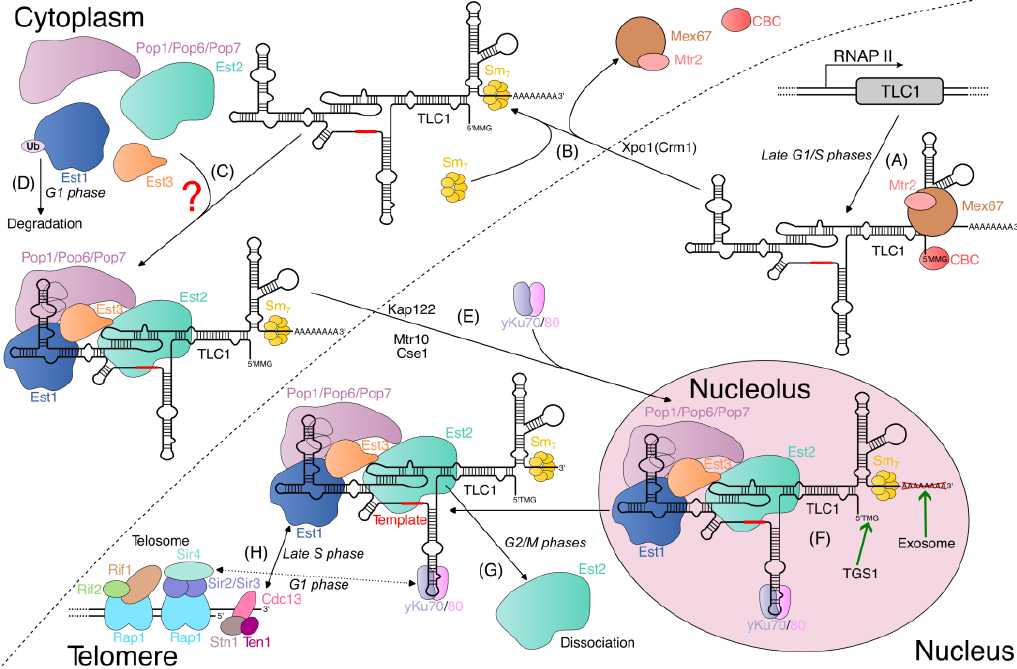
Figure 2. Model of telomerase biogenesis in budding yeast. ( A ) In late G1/S phases, telomerase RNA (TLC1) is synthesized by RNA polymerase II (RNAP II). Immature TLC1 has monomethylated 5′ cap (5′MMG) bound by cap-binding complex (CBC) and 3′ poly(A) tail (if it is not processed by exonucleolytic cleavage). Upon transcription, export receptor heterodimer Mex67-Mtr2 binds TLC1, stabilizing it and promoting its nuclear export. ( B ) Exportin Xpo1 ensures TLC1 export to cytoplasm,